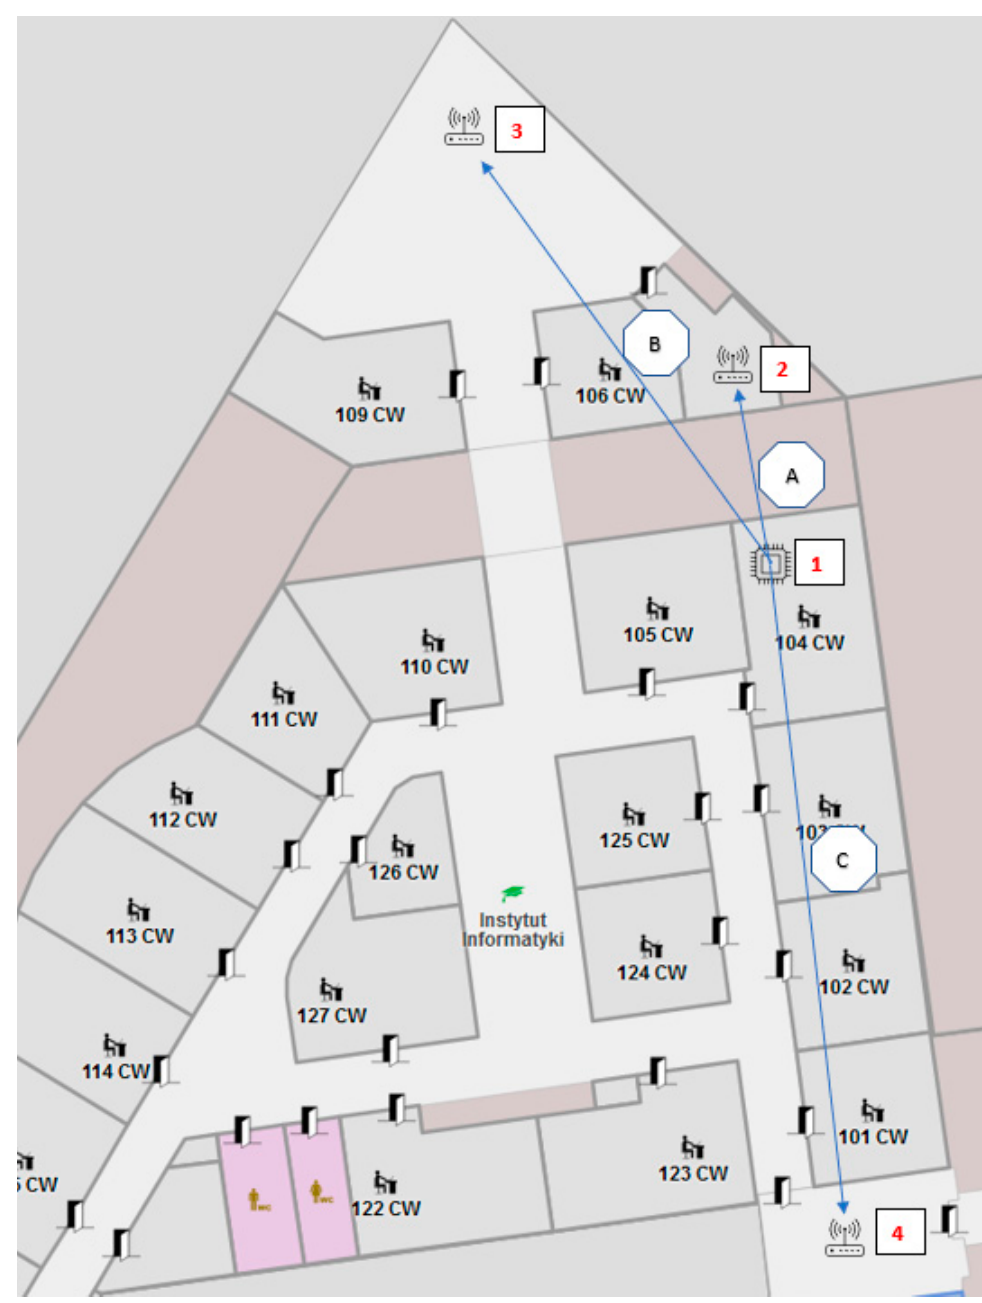
Figure 14. End device position (1), LoRa gateway positions (2, 3, 4) and distances between end device and LoRa gateway (A, B, C) in Lecture and Conference Centre of the Poznan University of Technology—first floor.